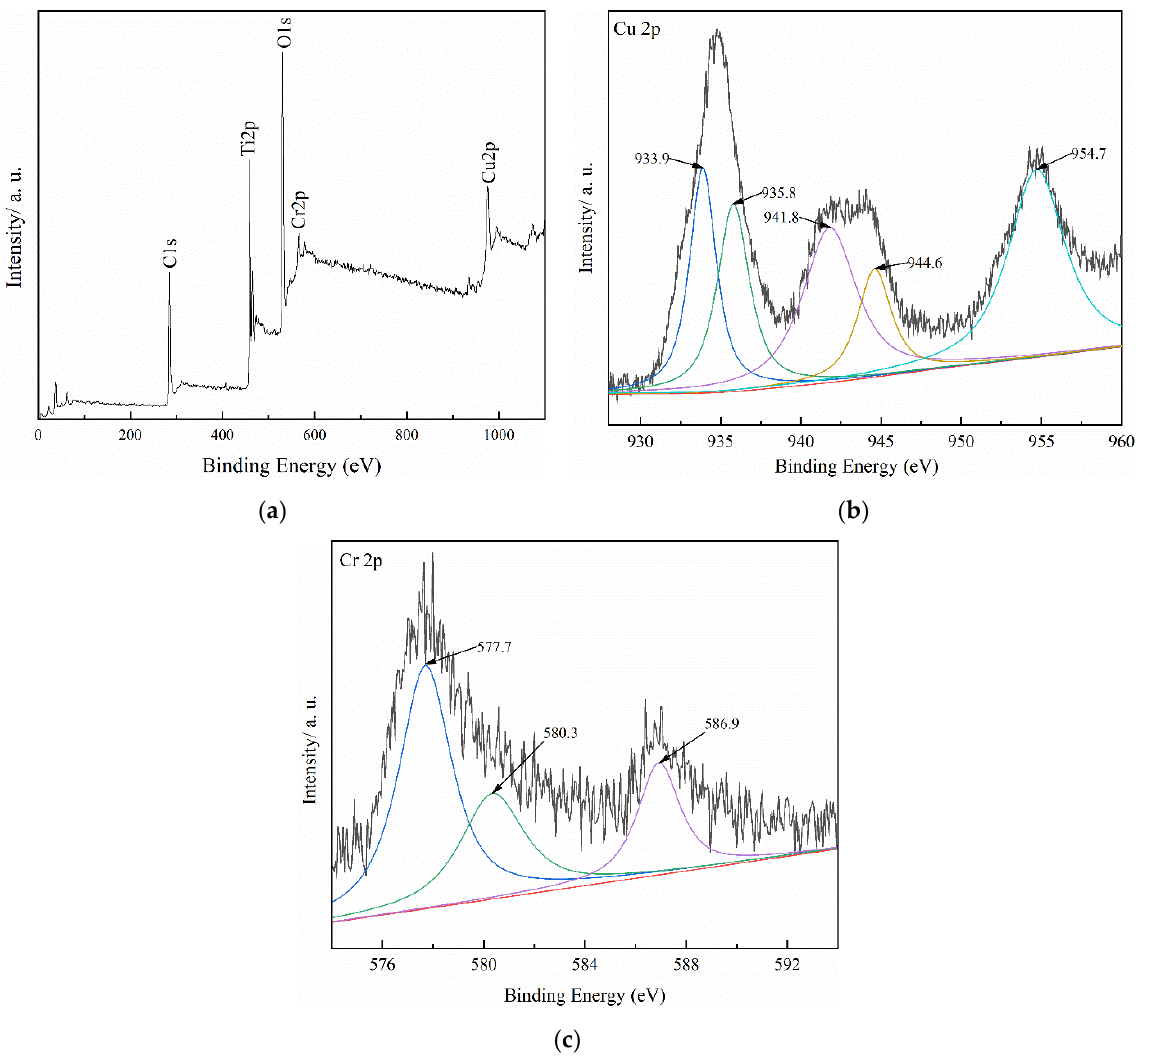
Figure 3. X-ray photoelectron spectroscopy (XPS) results of samples; ( a ) XPS spectra of MWCNTs/Cu-Cr-TiO 2 (Cu/Cr = 3); ( b ) XPS spectra of Cu 2p; ( c ) XPS spectra of Cr 2p.